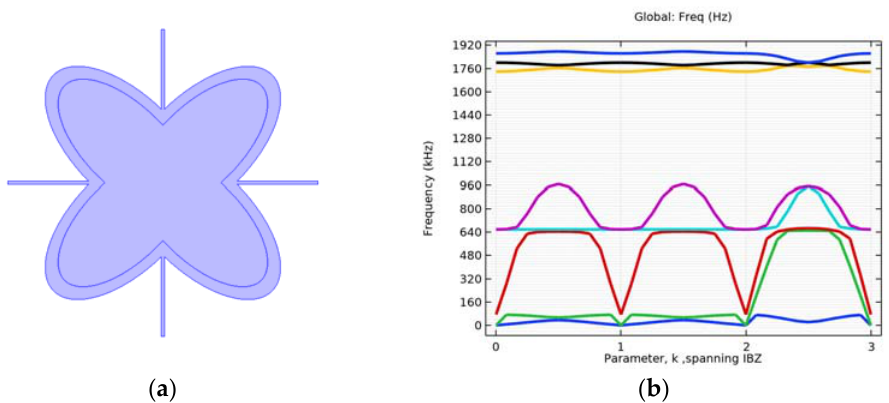
Figure 11. Response for inner ellipse 170 × 80, rod 3 mm. (a) microstructure, (b) responce for first eigenfrequenciew. One band gap exists between 5th and 6th eigenfrequency (970–1740 Hz).